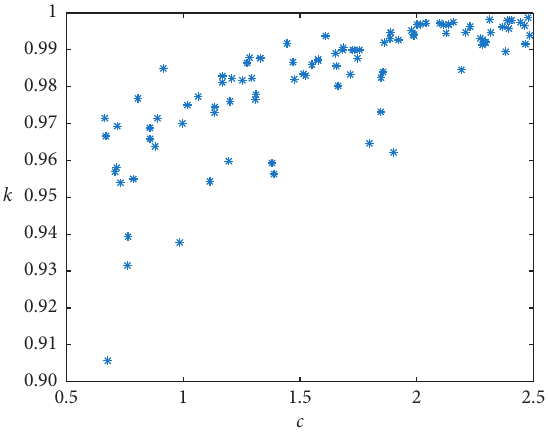
Figure 3: Plots of K vs. c for temperature.